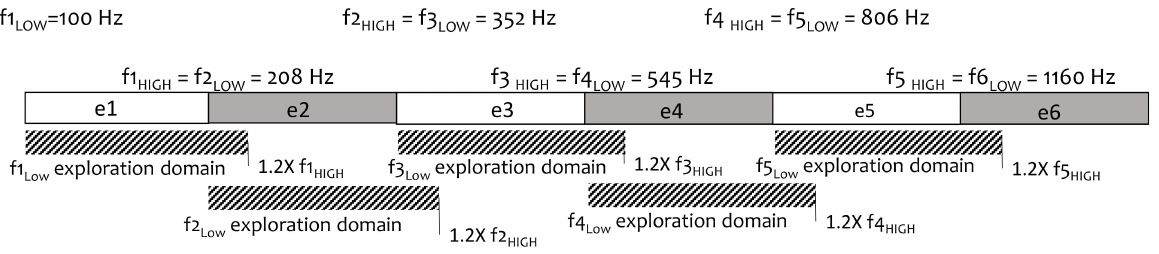
Figure 1. Frequency MAP fitting by an evolutionary algorithm (EA). An example with 5 electrodes (e1 to e5) for an MED-EL device is presented. The initial frequency intervals (f LOW and f HIGH in Hz) and the exploration domains for f HIGH (upper limit of each frequency band) by the algorithm are shown. The f LOW was set equal to f HIGH of the previous electrode to avoid discontinuity and overlap. The algorithm was developed using MATLAB (2016a version, MathWorks, Natick, MA, USA) as described before [35]. In this algorithm, each fMAP represented an individual. The default fMAP (factory settings) was used to define the initial frequency bands. Initial fMAPs were generated by EA-based on these initial values. For a new fMAP, the upper limit of each frequency band (f HIGH ) was determined by the EA in an exploration domain ranging from the lower limit of the same band (f LOW ) to 1.2 × f HIGH (Figure 1). Discontinuities and overlaps in the frequency domain were not permitted. Conse- quently, The f LOW of each frequency band was set equal to the f HIGH of the previous band. Larger values of overlapping and mutation probability would have created a total dis- ruption of the original fMAP, requiring longer adaptation periods, a larger exploration domain with more generations, and longer tests. With these constraints, the default fMAP generated a random initial population of 4 parent fMAPs (Figure